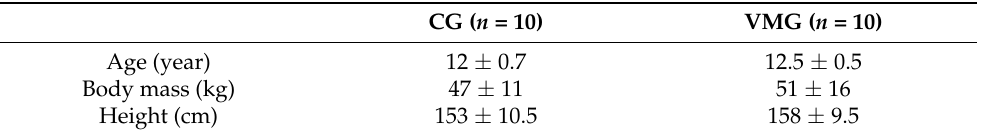
Table 1. Anthropometric measurements of the CG and VMG groups ( n = 10 each): Age, body mass, and